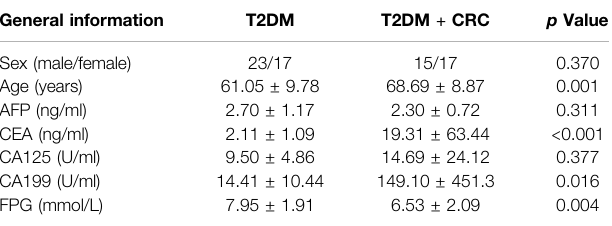
TABLE 1 | Comparison of general information between two groups. General